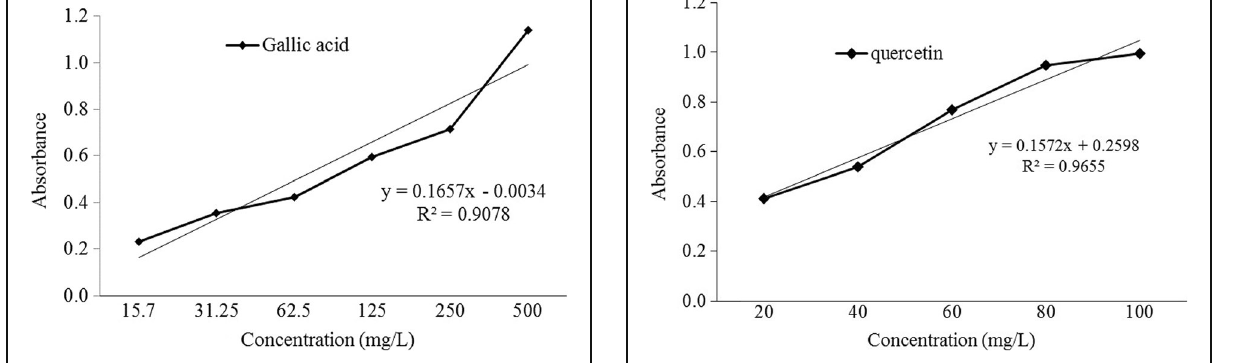
Fig. 2 Gallic acid standard calibration curve for the determination of total phenolic content